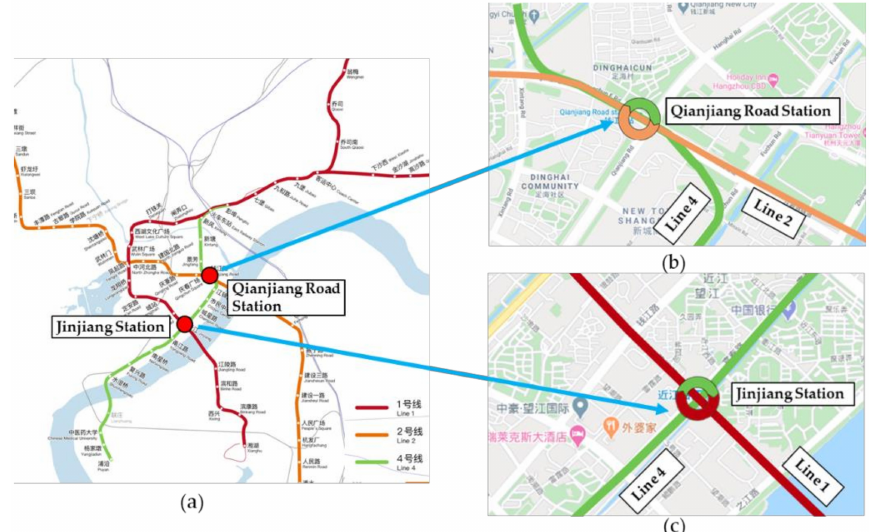
Figure 3. The location of the study metro transfer stations: ( a ) the Hangzhou metro network, ( b ) the Qiangjiang Road Station (Q.R. Sta.), and ( c ) the Jinjiang Road Station (J.